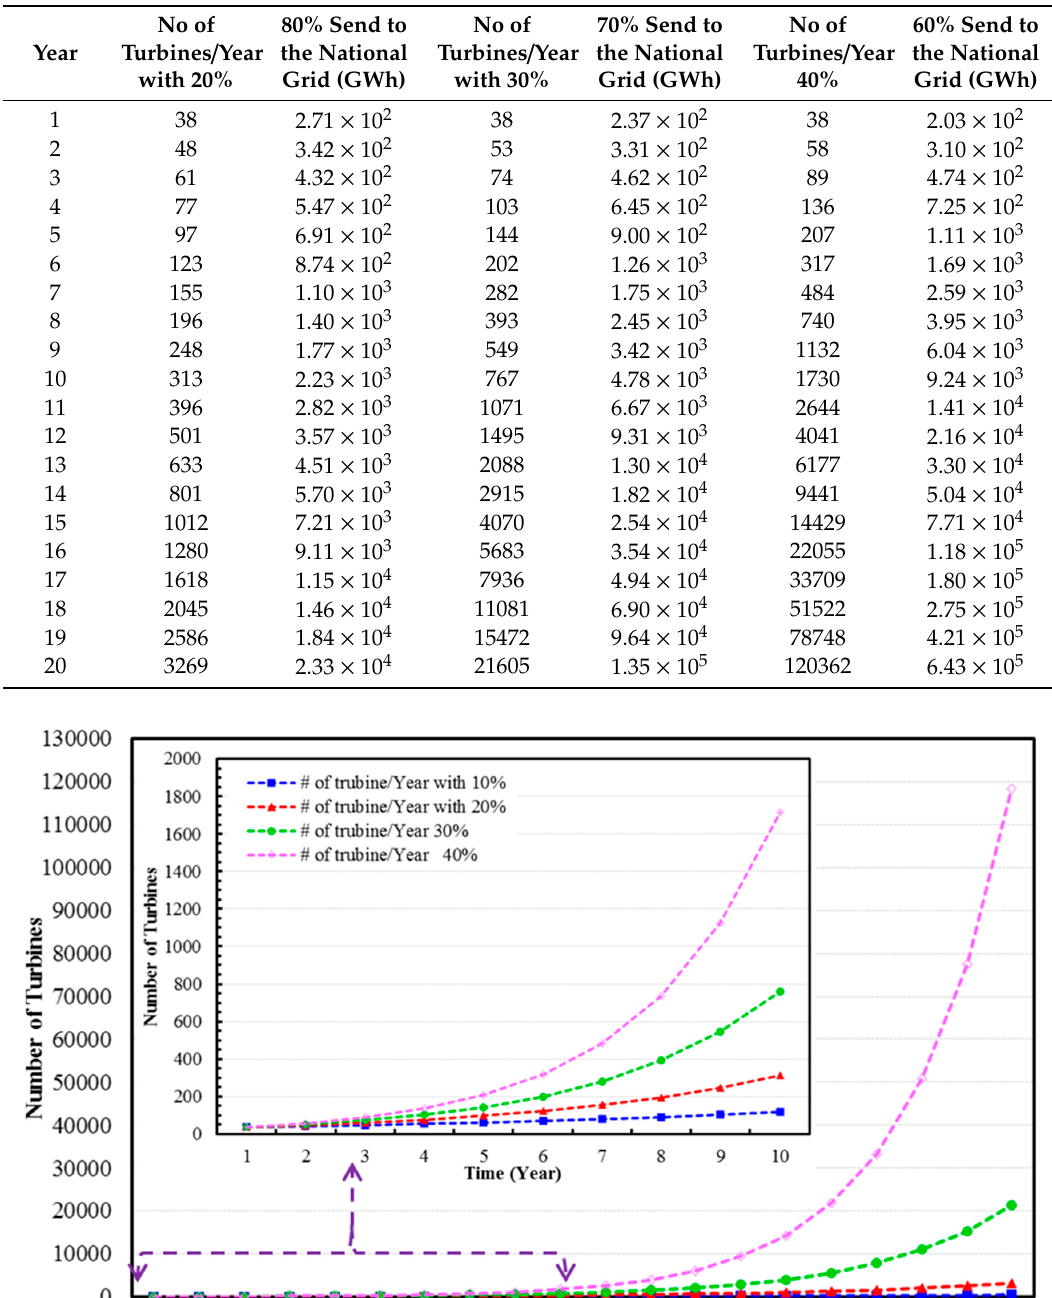
Table 17. The cumulative number of manufactured and installed turbines using 20; 30; 40% of generated energy during a 20-year period.